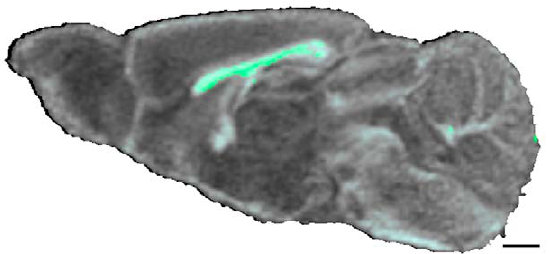
Figure 2. Fractional anisotropy differences between DAT KO and WT. A para-sagittal slice through the average of all WT FA data sets (grayscale background) is shown. Voxels that differ significantly between the DAT KO and WT brain scans at P , 0.005 are indicated in green. Scale bar =500 m m.